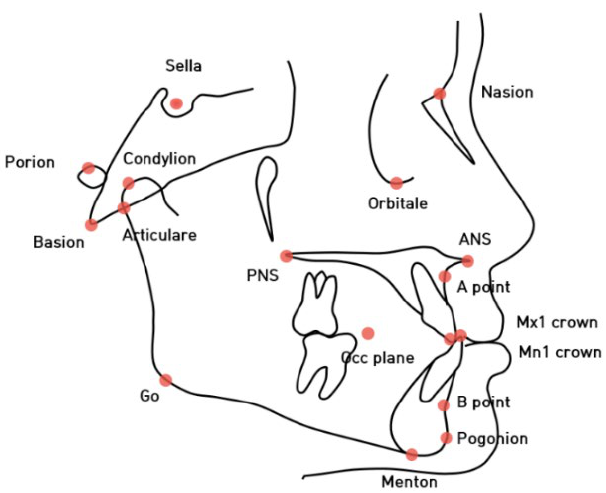
Figure 1. The cephalometric landmarks used in this study.